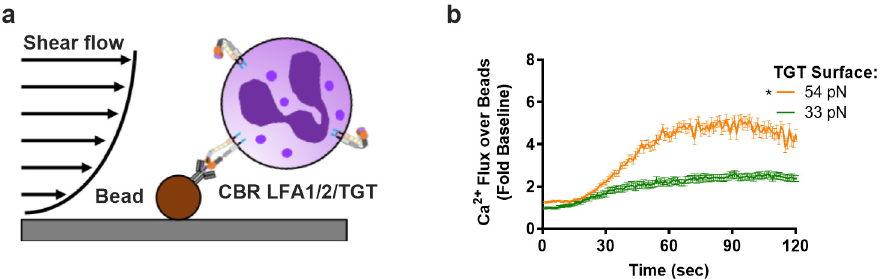
Figure 3. Neutrophil Ca 2+ flux increases with β 2 -integrin bond tension at equivalent bond number. ( a ) Schematic showing neutrophil attachment to beads functionalized with TGT/HA β 2 -integrin-inducing antibody (CBR LFA1/2) under shear flow. The cells are allowed to pivot over the bead, and only cells that resist the shear flow and remain bound for 2 min are quantified. ( b ) Ca 2+ flux of neutrophils that have pivoted over the functionalized beads. Data are reported as mean +/ − SEM over 5 fields of view with >3 cells per experiment ( n = 3, * significance between 54pN and 33pN starting at 40 s).